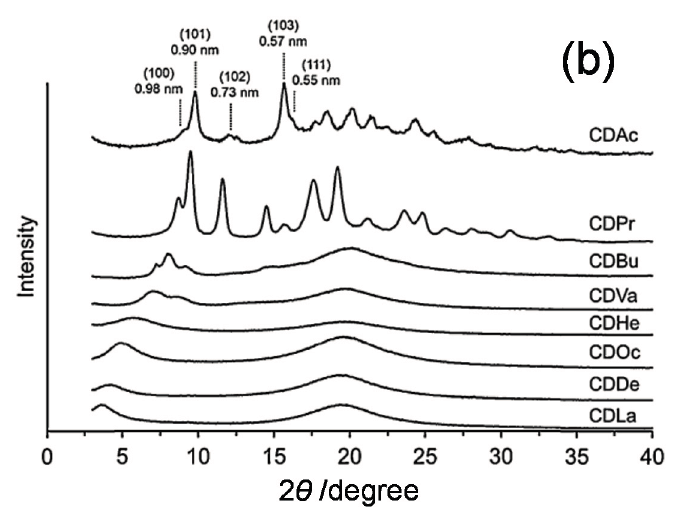
Figure 5. WAXD profiles of ( a ) konjac glucomannan (GM) and ( b ) curdlan (CD) ester derivatives. Abbreviations: Ac, acetate ( m = 2); Pr, propionate ( m = 3); Bu, butyrate ( m = 4); Va, valerate ( m = 5); He, hexanoate ( m = 6); Oc, octanoate ( m = 8); De, decanoate ( m = 10); La, laurate ( m = 12). Reproduced with permission from refs. [21] and [22] for (a) and (b), respectively. Copyright 2013 and 2014 Elsevier